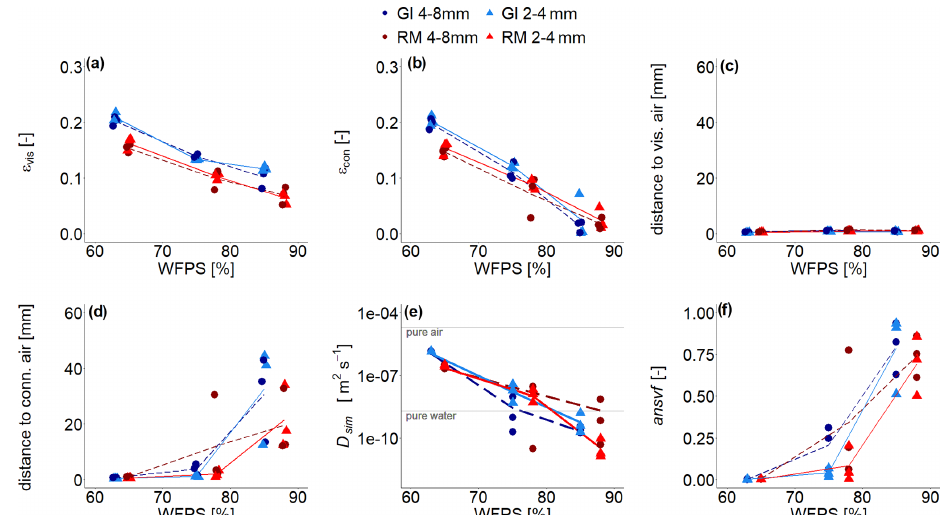
Figure 4. (a) Visible-air content ( ε vis ), (b) connected-air content ( ε con ), (c) average distance to visible air, (d) average distance to connected visible air, (e) simulated diffusivity ( D sim ), and (f) anaerobic soil volume fraction (ansvf) as a function of water-filled pore space (WFPS) for two repacked aggregate sizes (2–4 and 4–8mm) from Rotthalmünster (RM) and Gießen (GI) soil and three replicates each depicted by symbols. The lines (dashed and solid) connect the average value of three replicates (large and small aggregates, respectively). The horizontal grey lines in (e) reflect material properties. The experiment was performed at 20 ◦ C and according to that diffusivity was calculated at 20 ◦